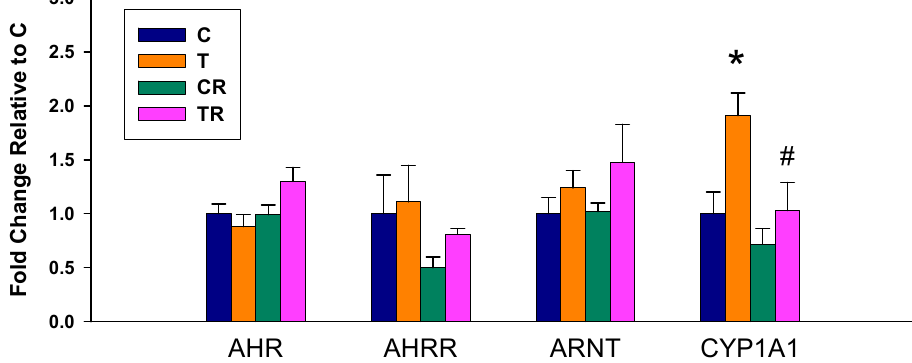
Figure 1. Effect of 2,3,7,8-tetrachlorodibenzo-p-dioxin (T) and resveratrol (R) on the mRNA